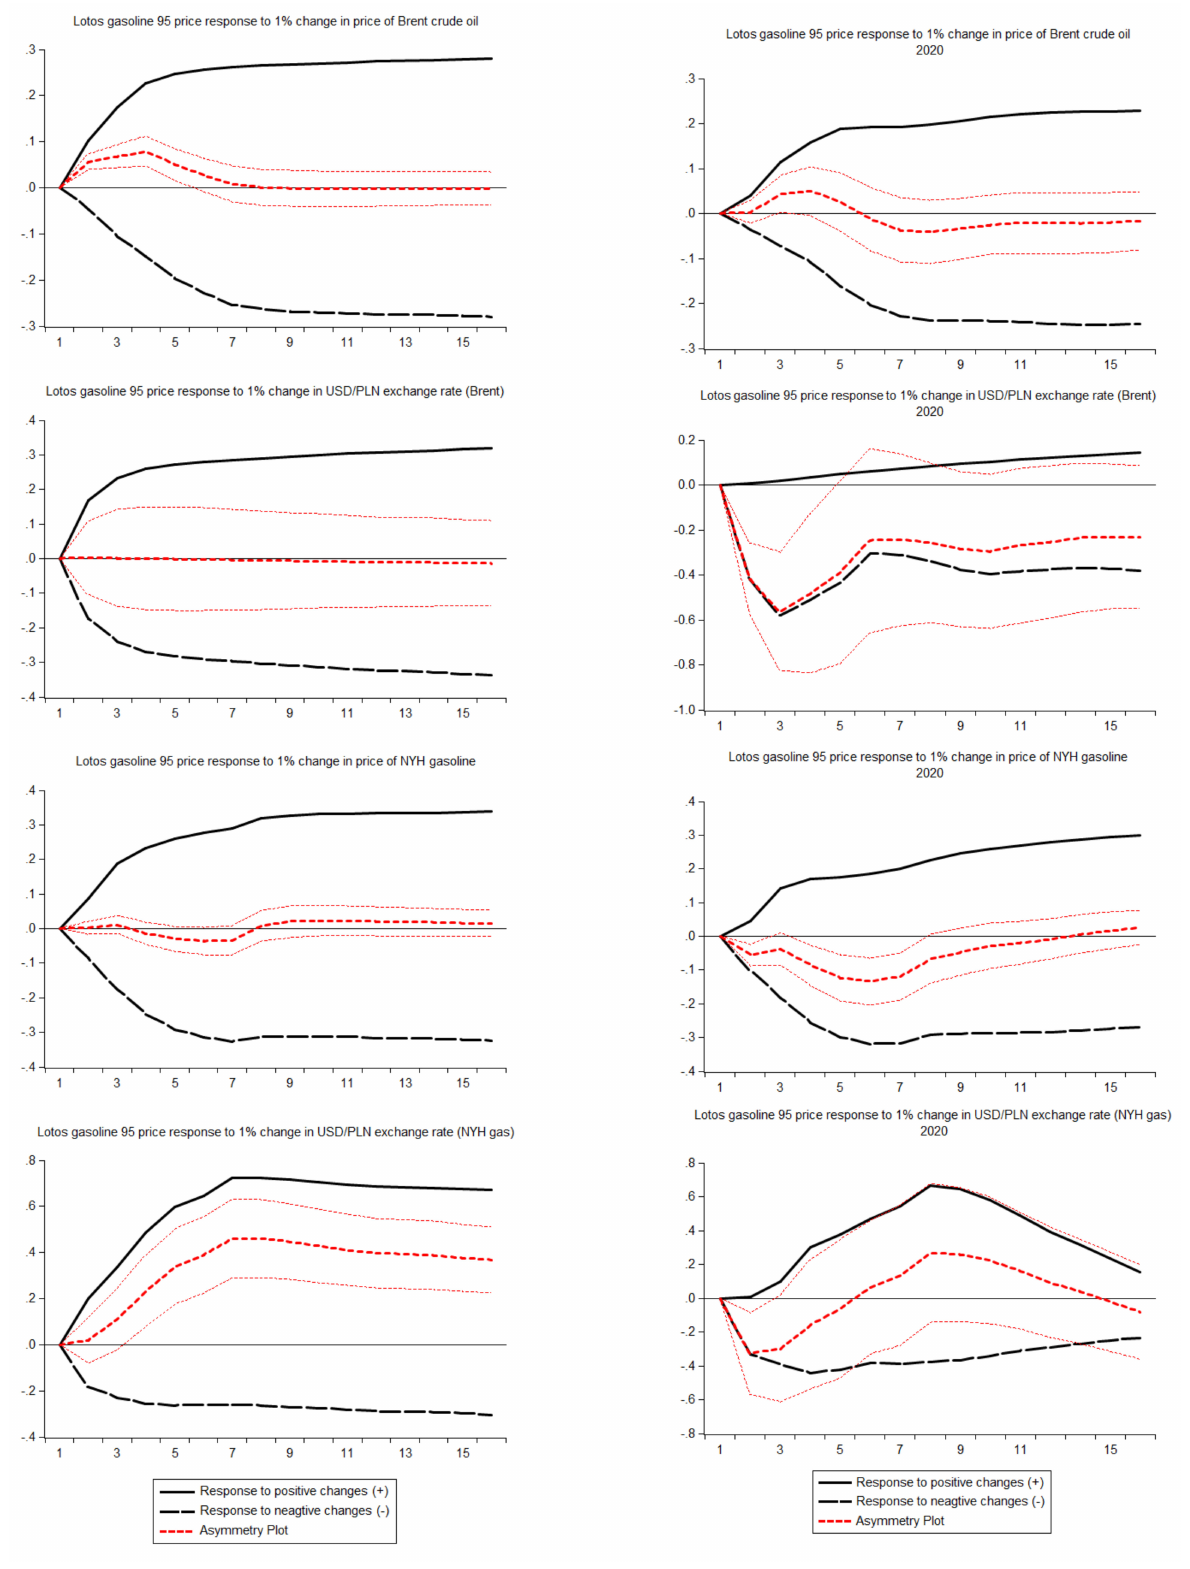
Figure 9. Dynamic multipliers for Lotos Gasoline 95 ( a ) whole sample; ( b ) year